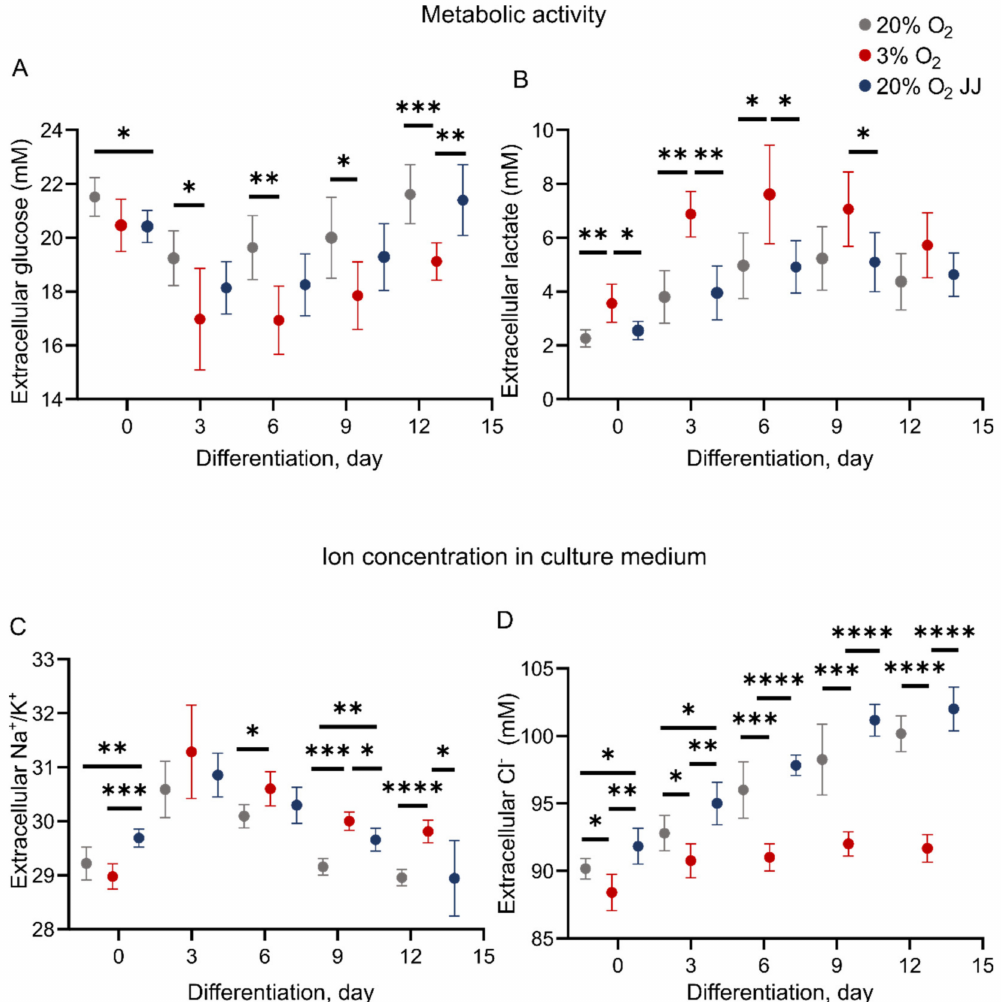
Figure 5. Metabolic activity and cell medium ion content during erythroblast culture. ( A ) Glucose consumption is more elevated for cells at 3% O 2 , suggesting a switch to glycolytic pathway and resulting in a higher production of lactate ( B ). ( C ) The ratio Na + /K + in the cell medium was higher, with two significant time points, in cells at 3% O 2 . ( D ) Cl − content, while remaining stable during differentiation of cells at 3% O 2 , resulted in daily increases for cells cultured at 20% O 2 . * = p < 0.05, ** = p < 0.01 and *** = p <